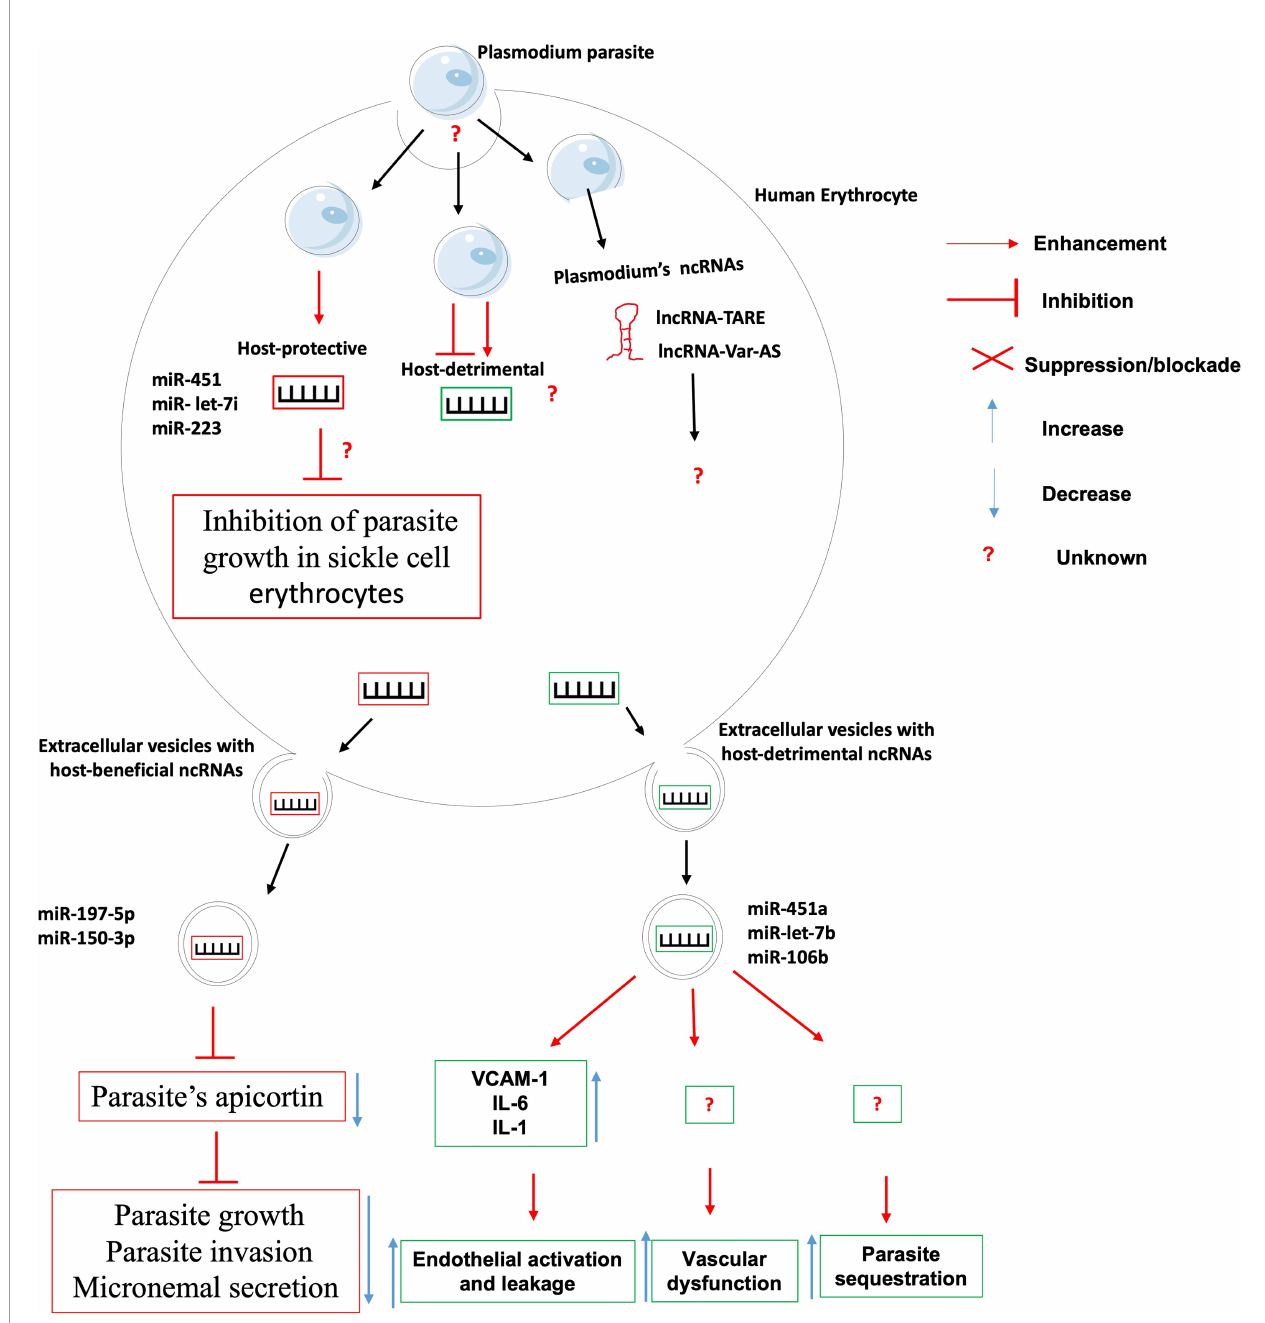
FIGURE 2 | The role of non-coding RNAs in the etiology of malaria. Very few ncRNAs known to involve in the etiology of Malaria. There is knowledge gap about 1- host ncRNAs that regulate the uptake/entry of plasmodium within erythrocytes; 2- host-detrimental ncRNAs and their mechanisms of action; and 3- the role of plasmodium-derived ncRNAs on the outcome of plasmodium-erythrocyte